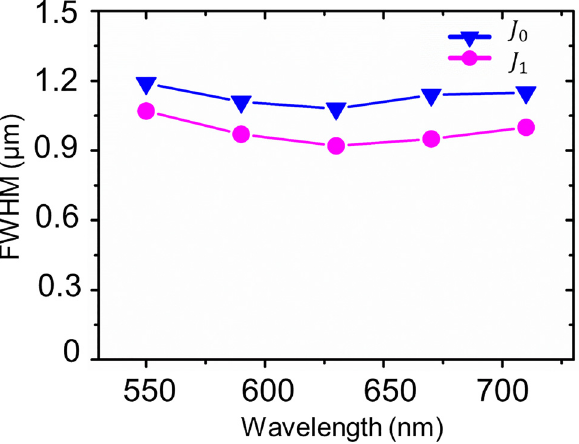
Figure 5: FWHMs of J 0 (blue solid line) and J 1 (pink solid line) Bessel beams at various wavelengths.